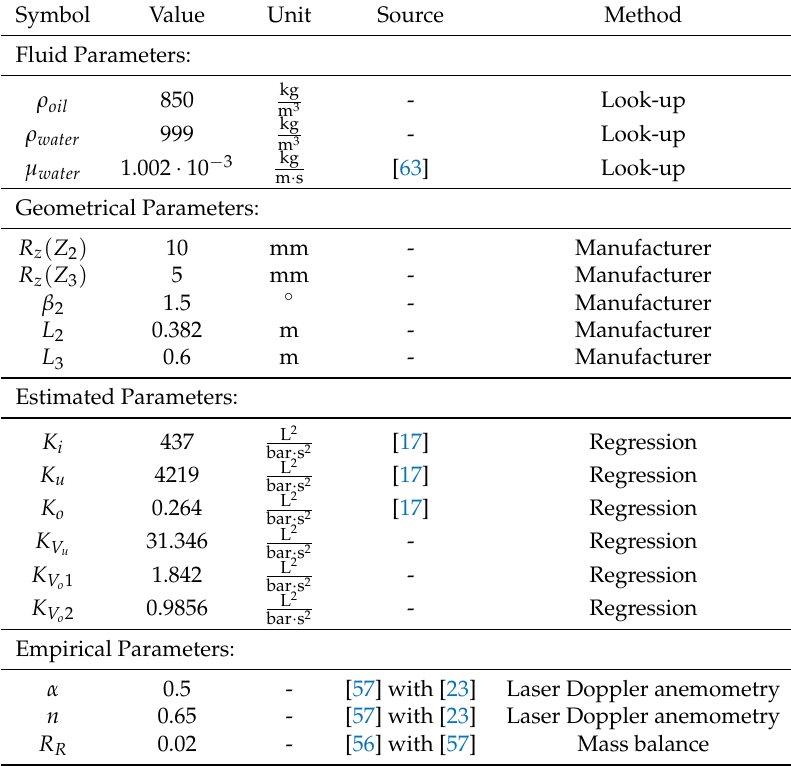
Table 1. Summary of model